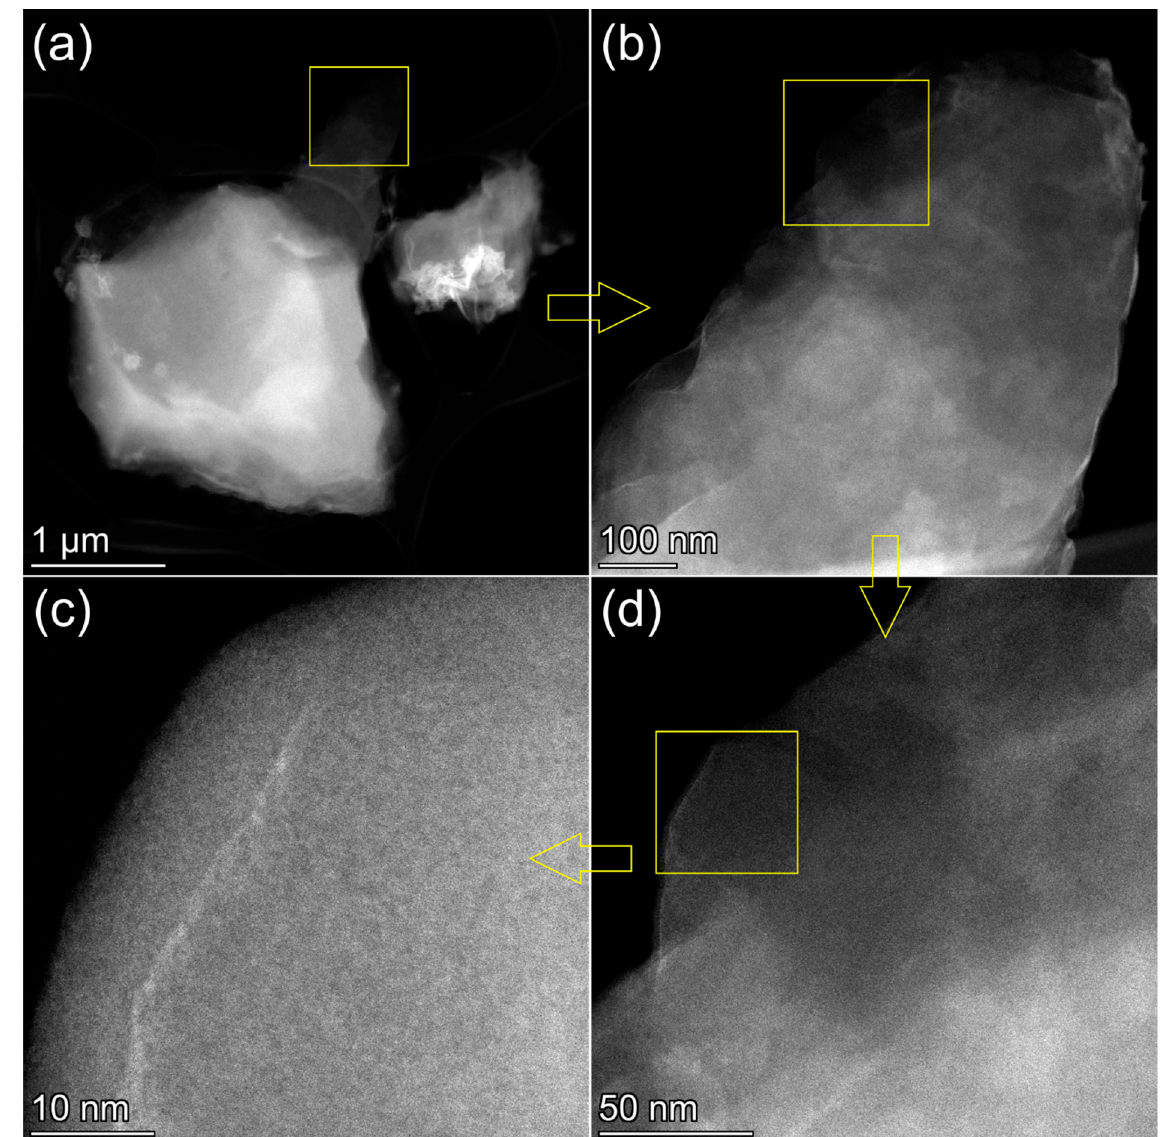
Figure 3. The HAADF-STEM images of an r OMC/Ni particle at different magnifications. ( a ) low magnification image; ( b – d ) progressively higher magnification images. The yellow squares and arrows indicate the area on the lower magnification image, where the next higher magnification image is acquired.